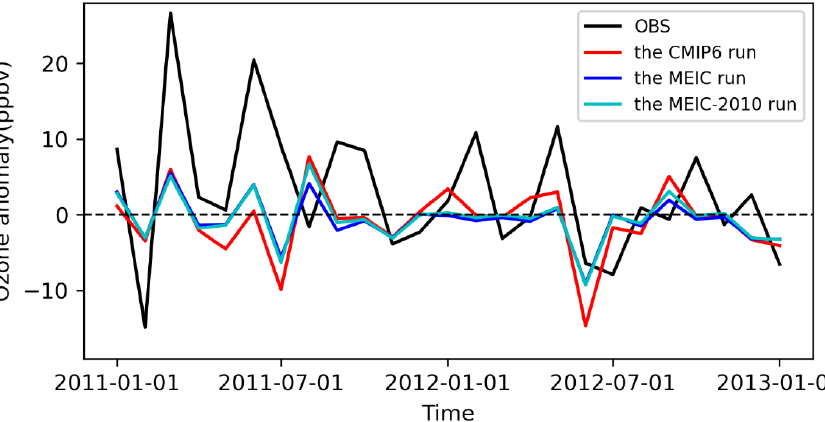
Figure 10. The deseasonalized monthly anomalies of ozone in Beijing at 14:00 BJT during 2011–2012 from the observation (black line) and three model simulations by the CAM-chem model. The first set of model simulations uses the default emissions of CMIP6 (red line). The second uses MEIC’s NOx and anthropogenic VOC emissions in place of CMIP6 emissions in China (blue line). The third is based on the second emissions remaining unchanged in 2010 (cyan line).